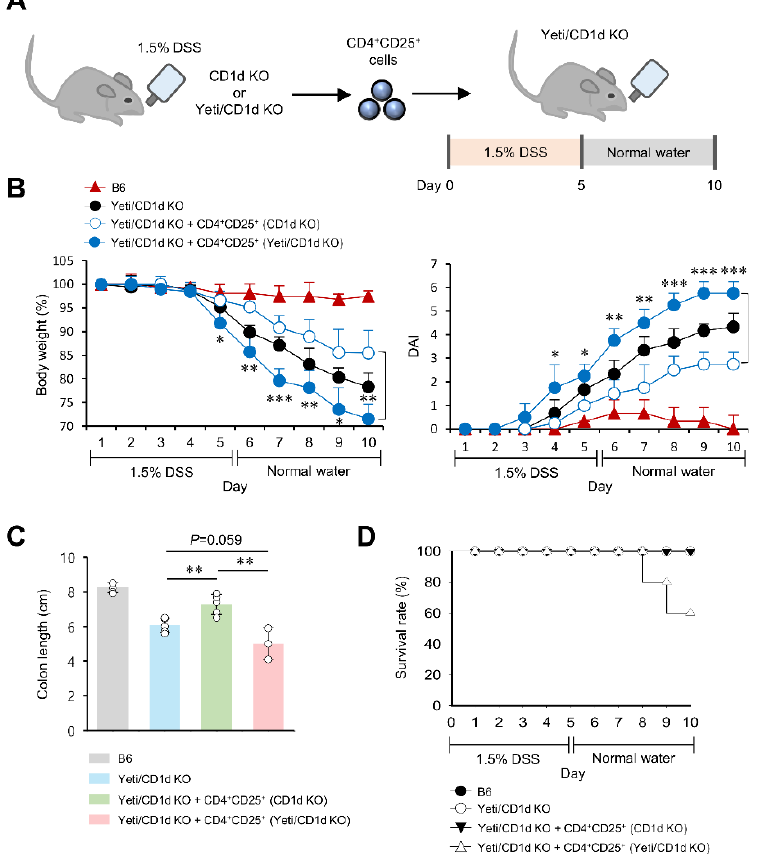
Figure 6. CD25 + CD4 + effector T cells from DSS-treated Yeti/CD1d KO mice are pathogenic in DSS- induced colitis. ( A – D ) MLN CD4 + CD25 + T cells (5 × 10 5 ) were purified from 1.5% DSS-treated CD1d KO or Yeti/CD1d KO mice and subsequently I.V. transferred to Yeti/CD1d KO mice. Daily body weight changes, disease activity index (DAI) score ( B ), colon length ( C ), and survival rate ( D ) of these mice were evaluated after 1.5% DSS treatment. The mean values ± SD ( n = 3–5 in ( A – C ); n = 5 in ( D ); per group in the experiment; Student’s t -test; * p < 0.05, ** p < 0.01, *** p < 0.001) are shown. One representative experiment from two experiments is